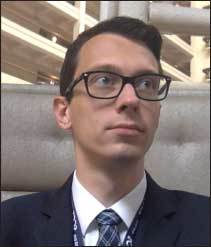
Dr Rolf Symons (2018).